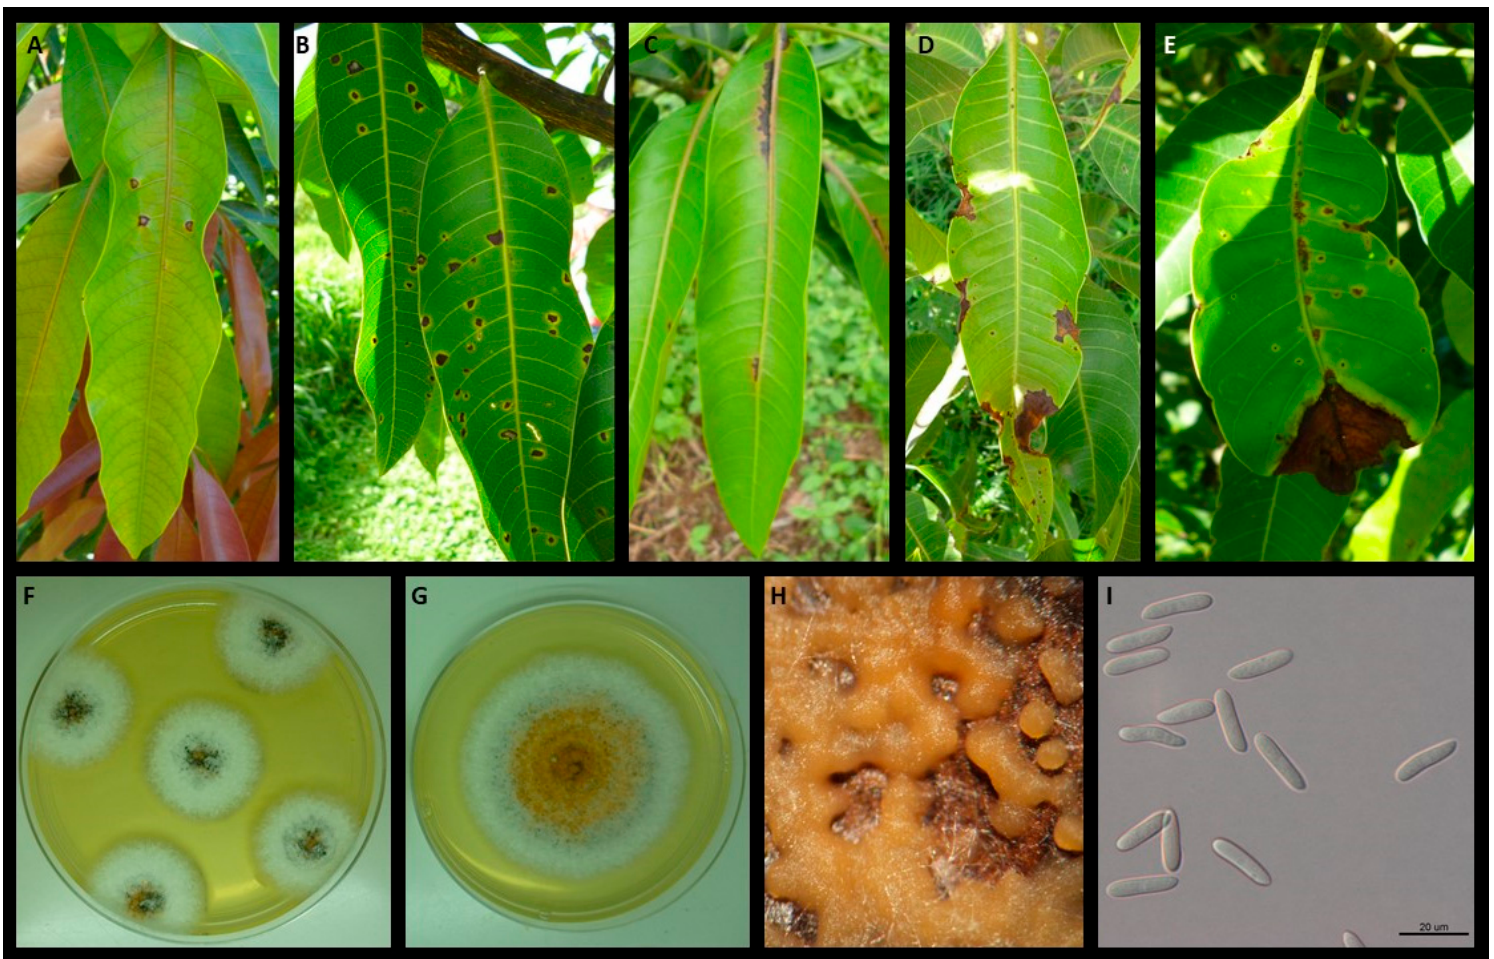
Figure 1. Variability in disposal, patterns and size on leaf blade of anthracnose infections caused by Colletotrichum asianum during susceptibility mango evaluation at the Sementeira Farm, Universidade Federal de Viçosa ( A – E ). Culture characteristics and microscopic features of the C. asianum : colony morphology from isolation attempts ( F ), 10-day-old monoconidial isolate ( G ), conidiomata on host tissues ( H ) and conidia ( I ).